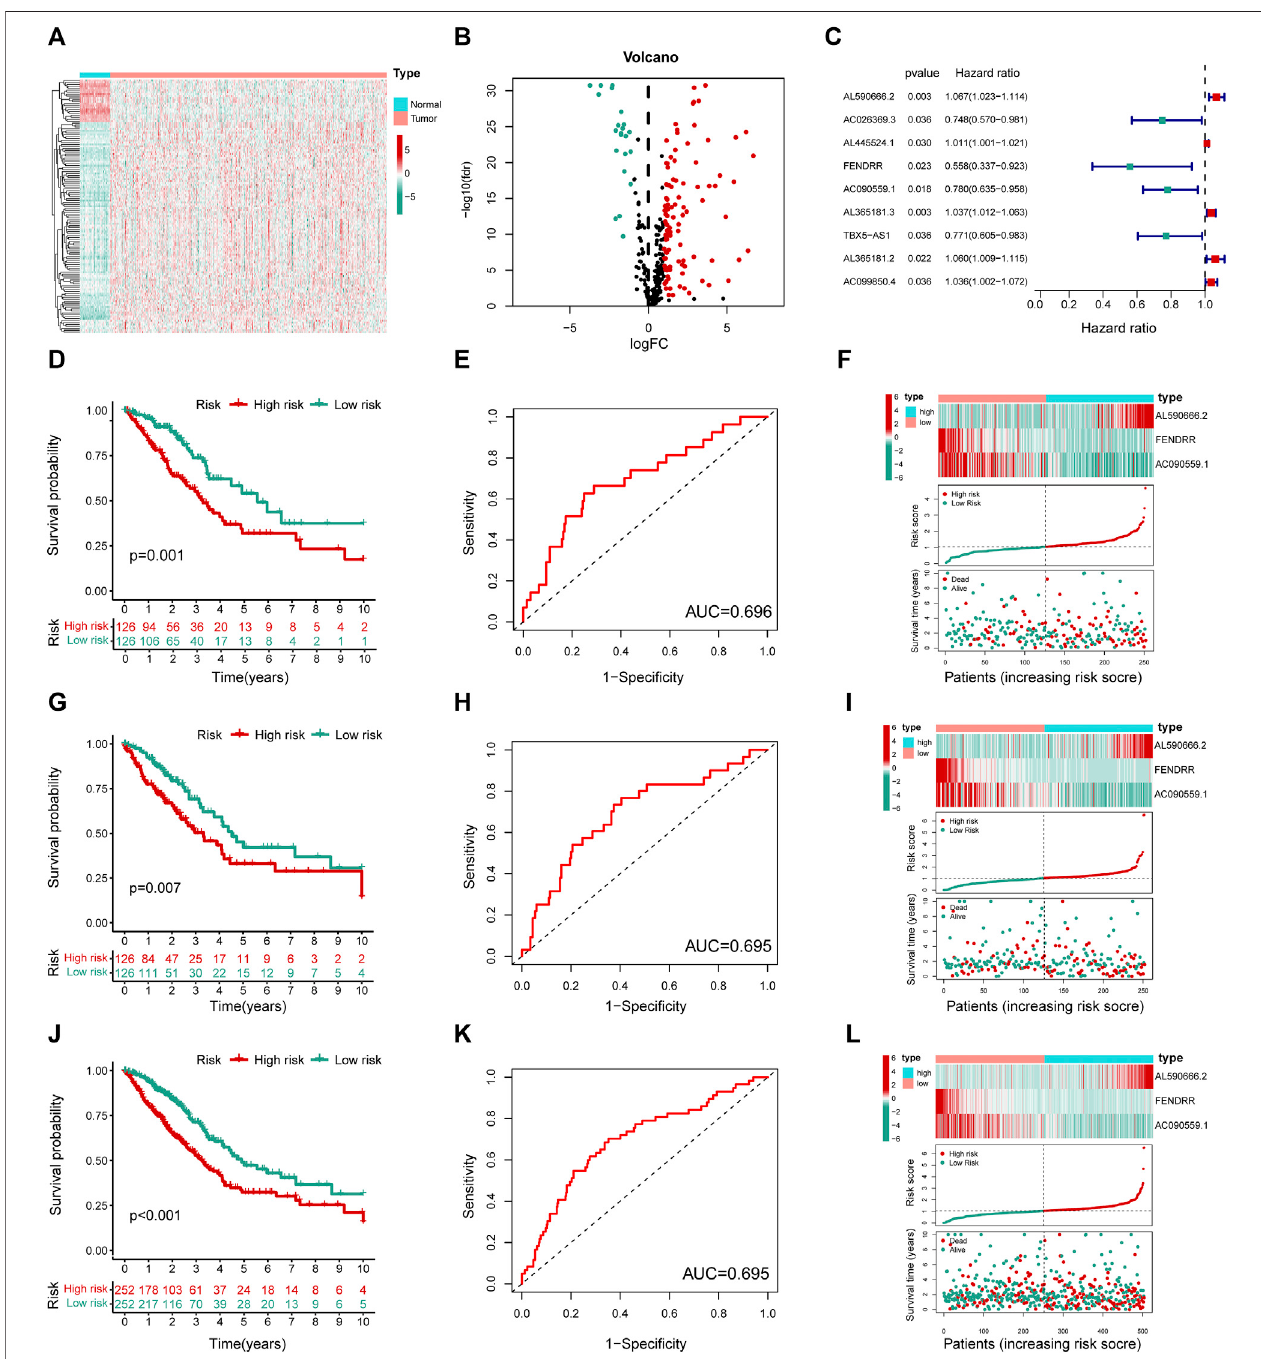
FIGURE3| ConstructionandvalidationoftheMHLncSig. (A) Aheatmapofdifferentialexpressionanalysisbasedon2,850MHRlncRNAs. (B) Avolcanoplotbased on the 109 upregulated MHRlncRNAs and 22 downregulated MHRlncRNAs. (C) A forest plot of nine MHRlncRNAs signi fi cantly related to survival in LUAD. (D,G,J) DifferentKaplan – Meiercurves inthetworiskgroups strati fi edbyMHLncSig inthetraining set,testing set,and theentireTCGA set. (E,H,K) ROCcurveoftheMHLncSig at 3 years in the training set, testing set, and the entire TCGA set. (F,I,L) The expression patterns of MHLncSig, the risk grade distribution, and the survival status between the low- and high-risk groups in the training set, testing set, and the entire TCGA set.